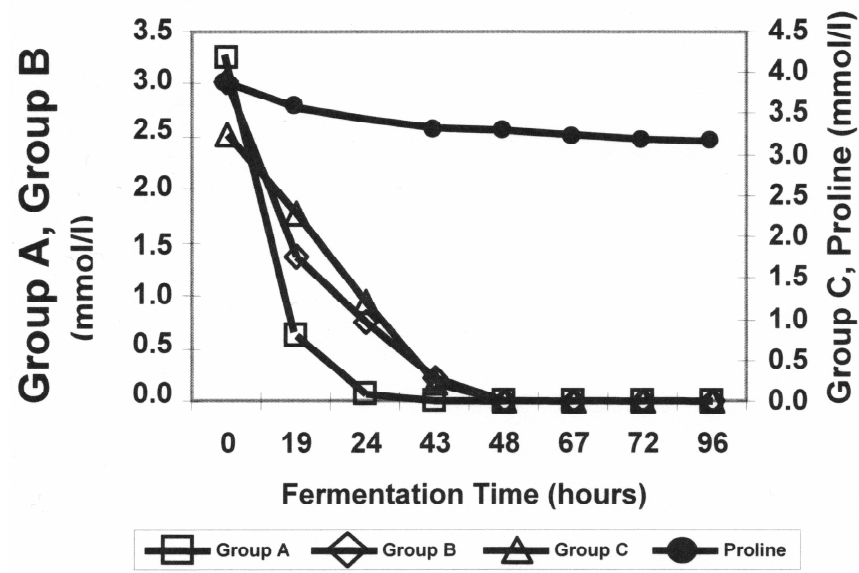
Figure 1. Amino acid adsorption patterns during wort fermentation. From Stewart, Hill and Lekkas (2013) [31].